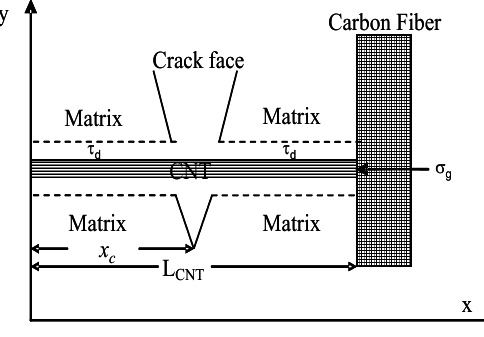
Figure 4. Diagram of CNT pullout process in CNT@CF structure.